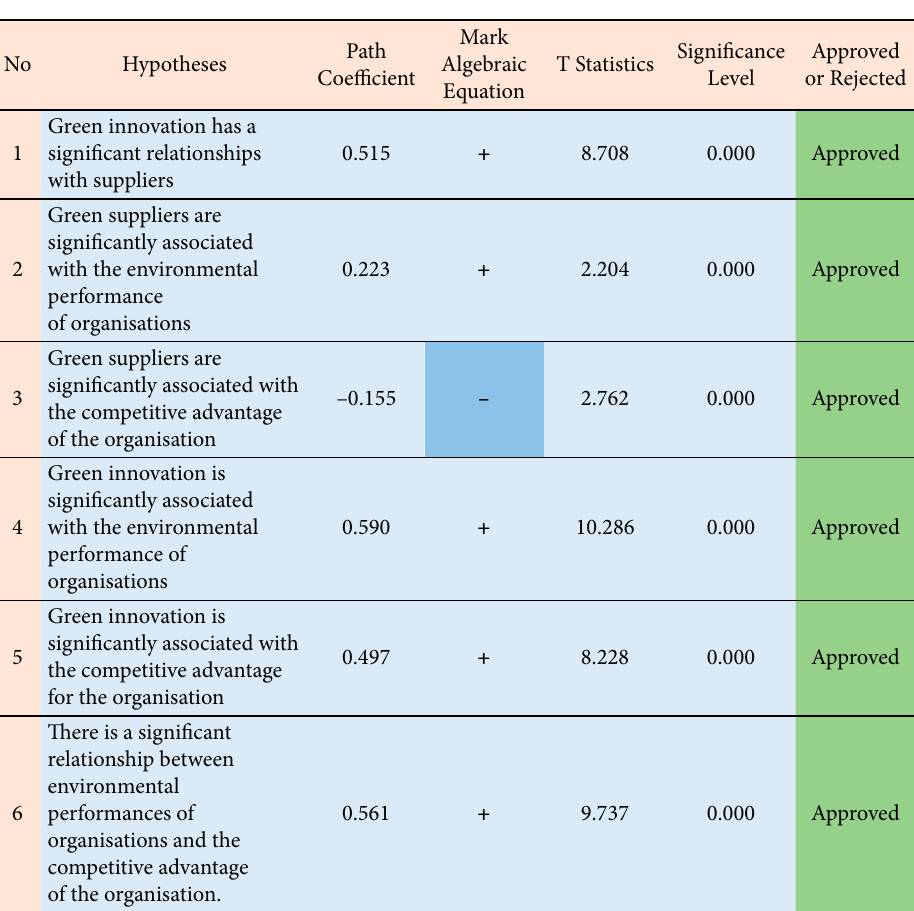
Table 4. Final results of the study regarding